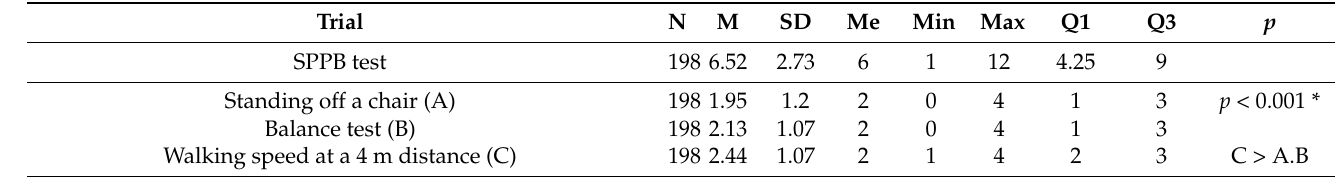
Table 2. The statistical characteristics of the SPPB test